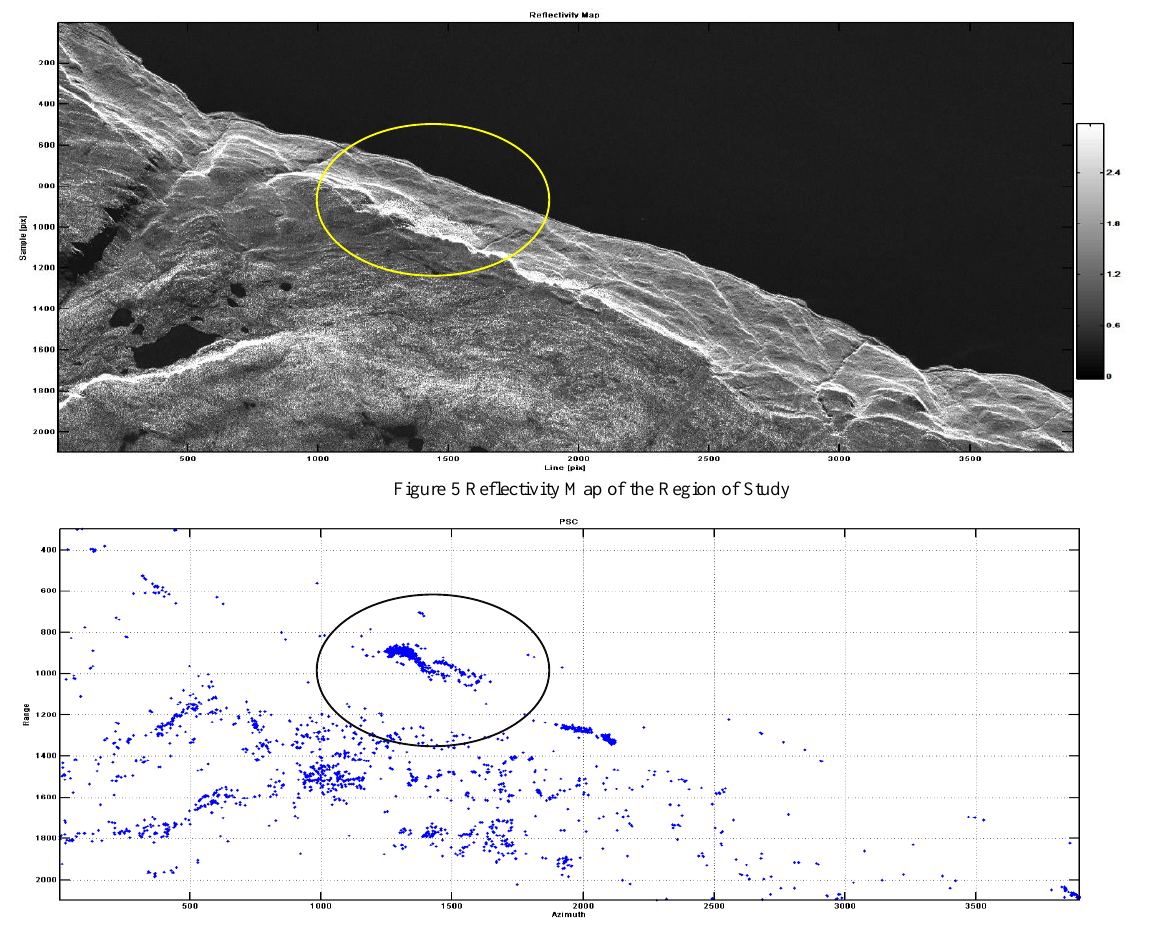
Figure 5 Reflectivity Map of the Region of Study